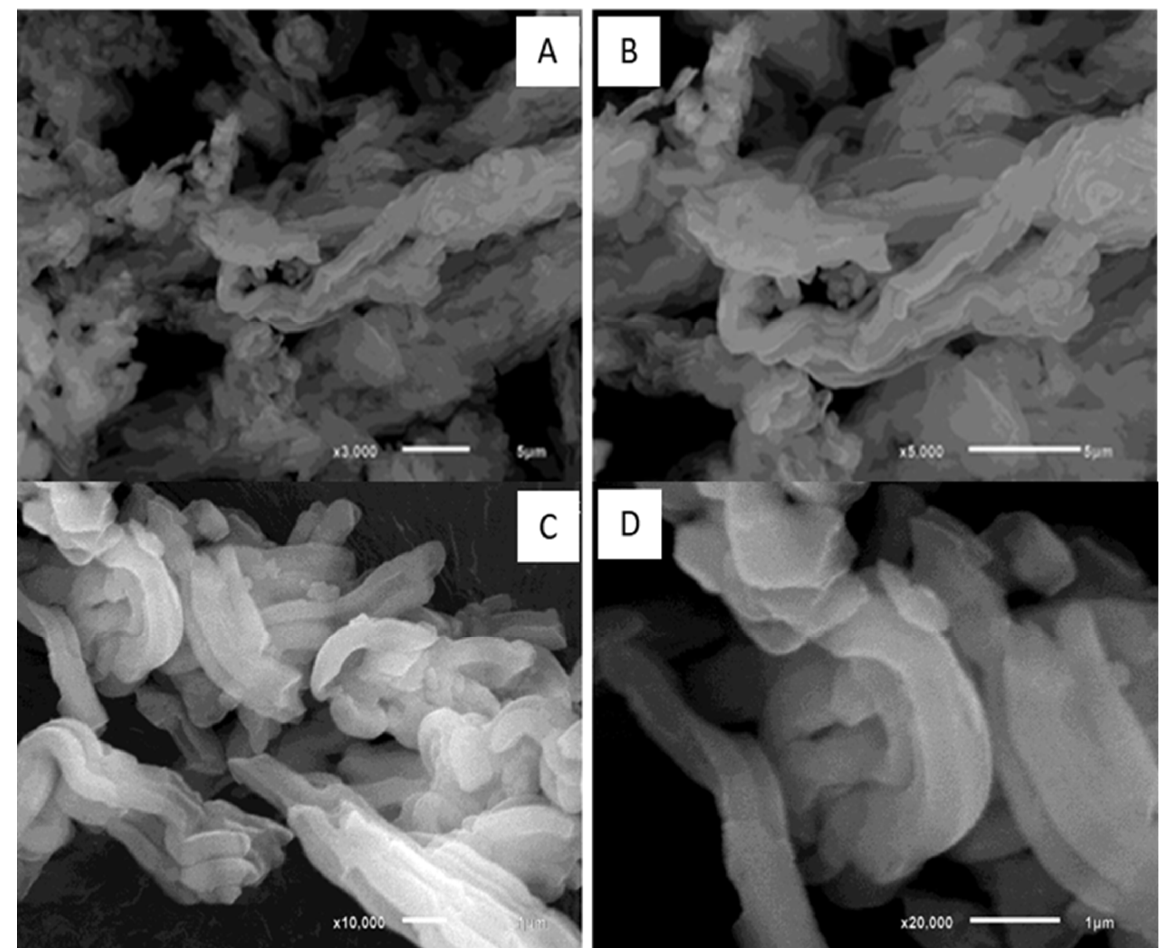
Figure 1. Scanning Electron Microscopy images of the SBA-15 mesoporous layered material and its aggregates at different magnifications ( A – D ).